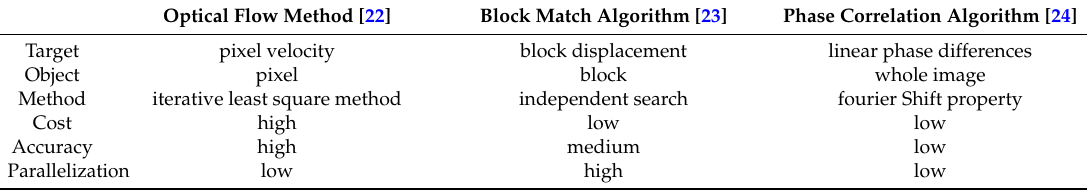
Table 1. Comparison between the optical flow methods and the block match